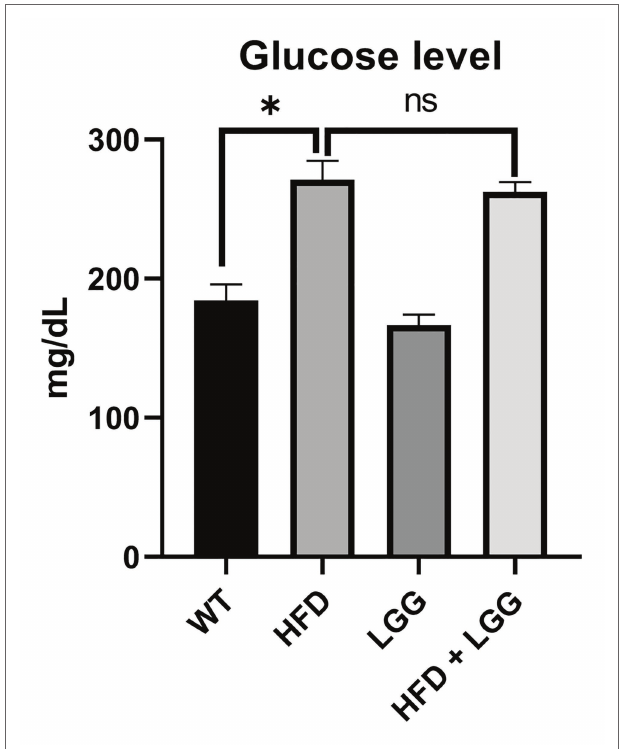
FIGURE 2 | Effect of HFD and Lactobacillus rhamnosus GG (LGG) treatment on the glucose level (ng/ml). WT, Wild-type C57BJ/L6 mice; HFD, HFD- supplemented wild-type mice; LGG, LGG-supplemented wild-type mice; HFD + LGG, HFD, and LGG-supplemented wild-type mice. Values remain under defined diabetic values. All data represent means ± SD, WT vs. HFD group * p < 0.05; HFD vs. HFD + LGG ns p > 0.05, n =